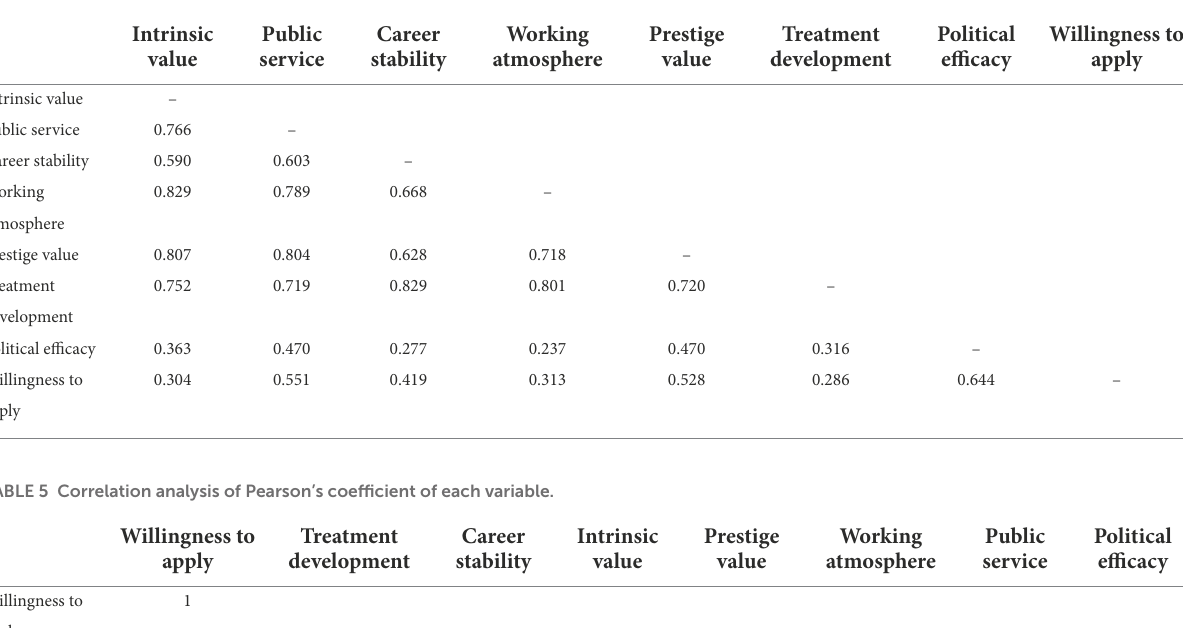
TABLE 4 HTMT (heterotrait-monotrait ratio) test.